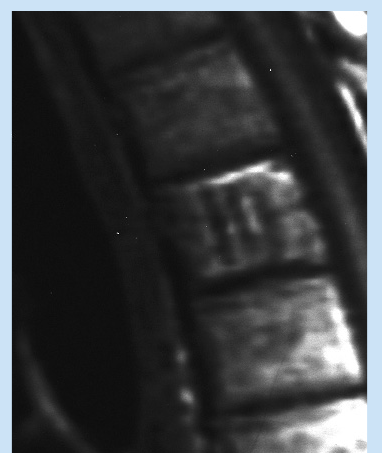
Fig.1c.Fig. 1b,c. In case 1 on T1 and T2-weighted sagittal scans there are hyperdense striated lesions in the body of T5 and T6 typical of hae- mangiomas.